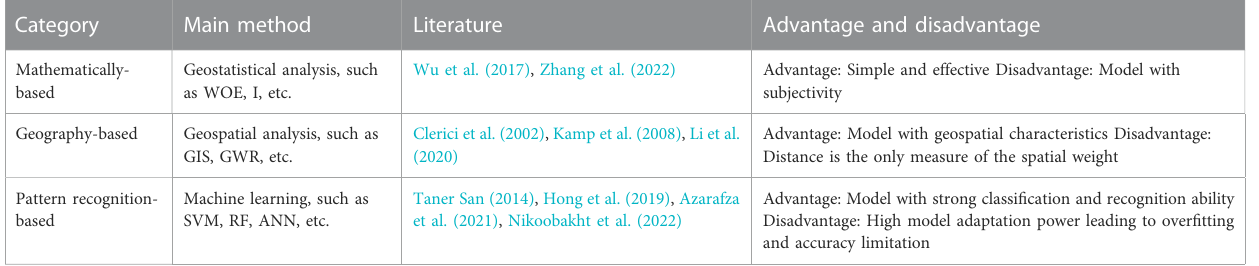
(Table 1): mathematically-based, geography-based and, pattern recognition-based. The model construction under these three categories is based on geostatistical analysis, geospatial analysis, and machine learning, respectively, with each presenting its own advantages and disadvantages.